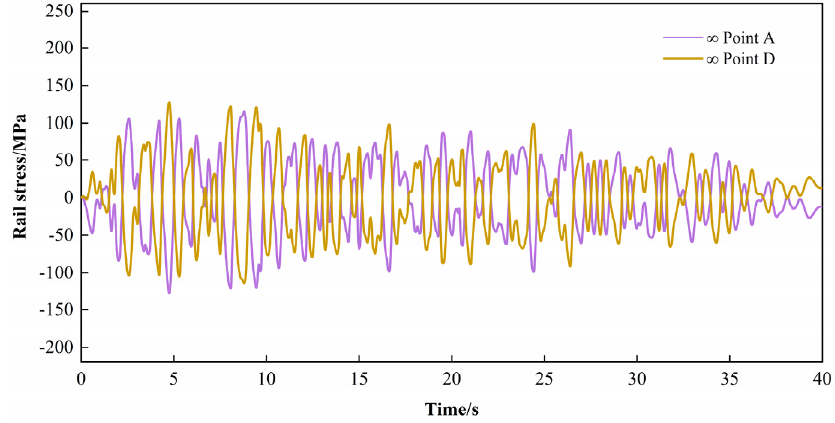
Figure 16. The stress–time-history curve of the rail at point A and point D when the apparent wave velocity is 8000 m/s.